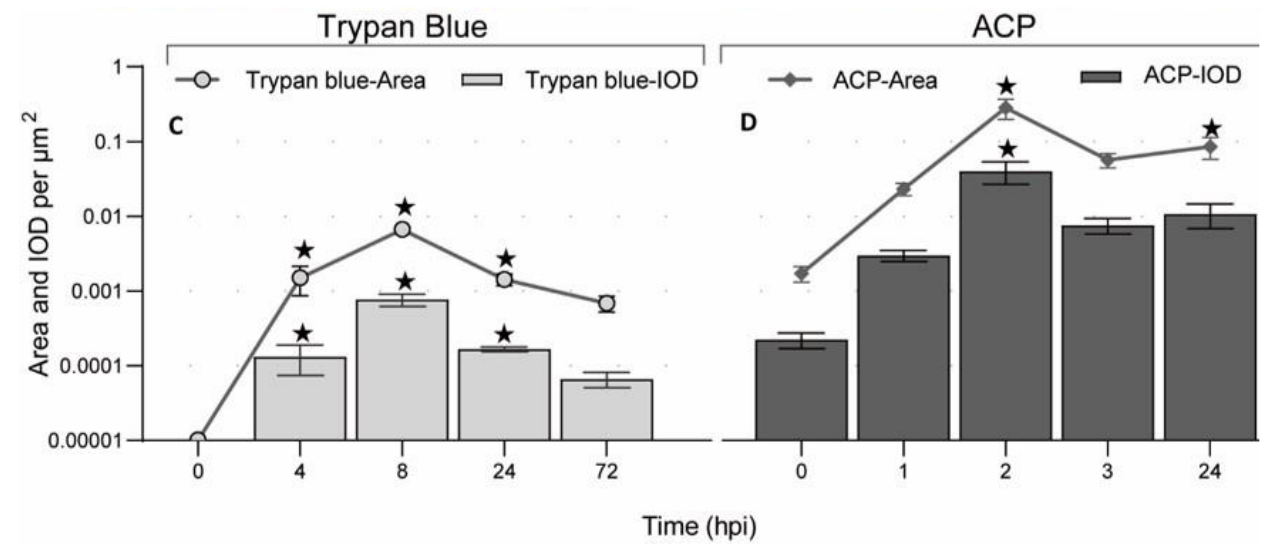
Figure 6. The location and quantification of Trypan blue and ACP (Acid phosphatase). ( A ). 8 hpi ( i.p. ), Trypan blue ( → ) appeared in the endotheliocytes of ECs; ( B ). 8 hpi ( i.p. ), ACP expressed by the endotheliocytes of ECs; ( C ). Area and IOD of Trypan blue detected using IPP 6.0 from 0 – 72 hpi ( i.p. ); ( D ). Area and IOD of ACP detected by IPP 6.0 from 0 – 24 hpi ( i.v. ). “ ★ ” : significantly different ( p < 0.05). “ (cid:70) ”: significantly different ( p <